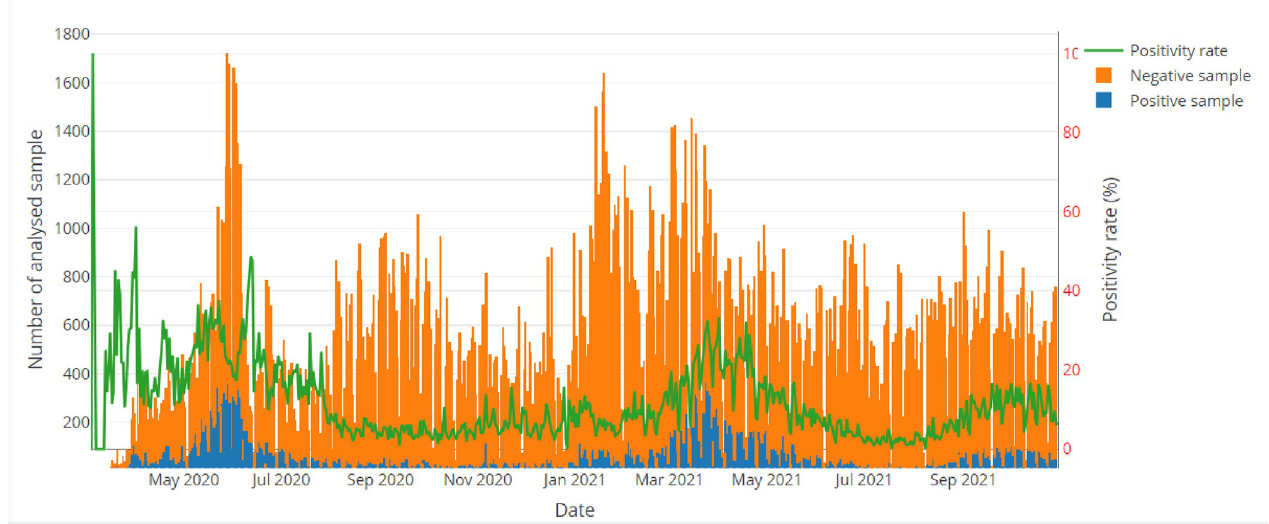
Fig 3. Evolution of daily number of samples analyzed, positive and positivity rate for COVID 19 test by RT-PCR in Cameroon.